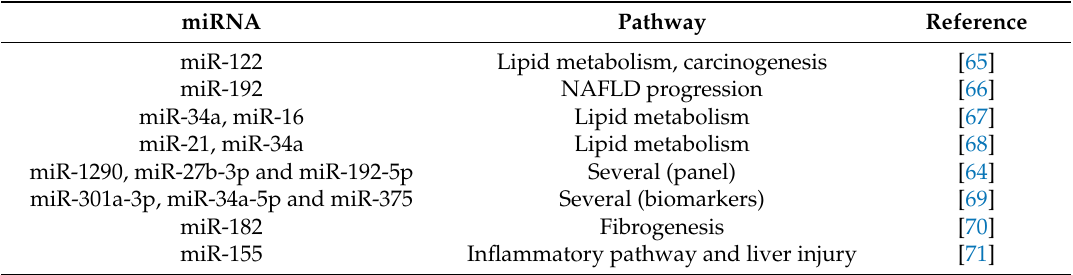
Table 2. Association of specific miRNAs with NAFLD development and progression in